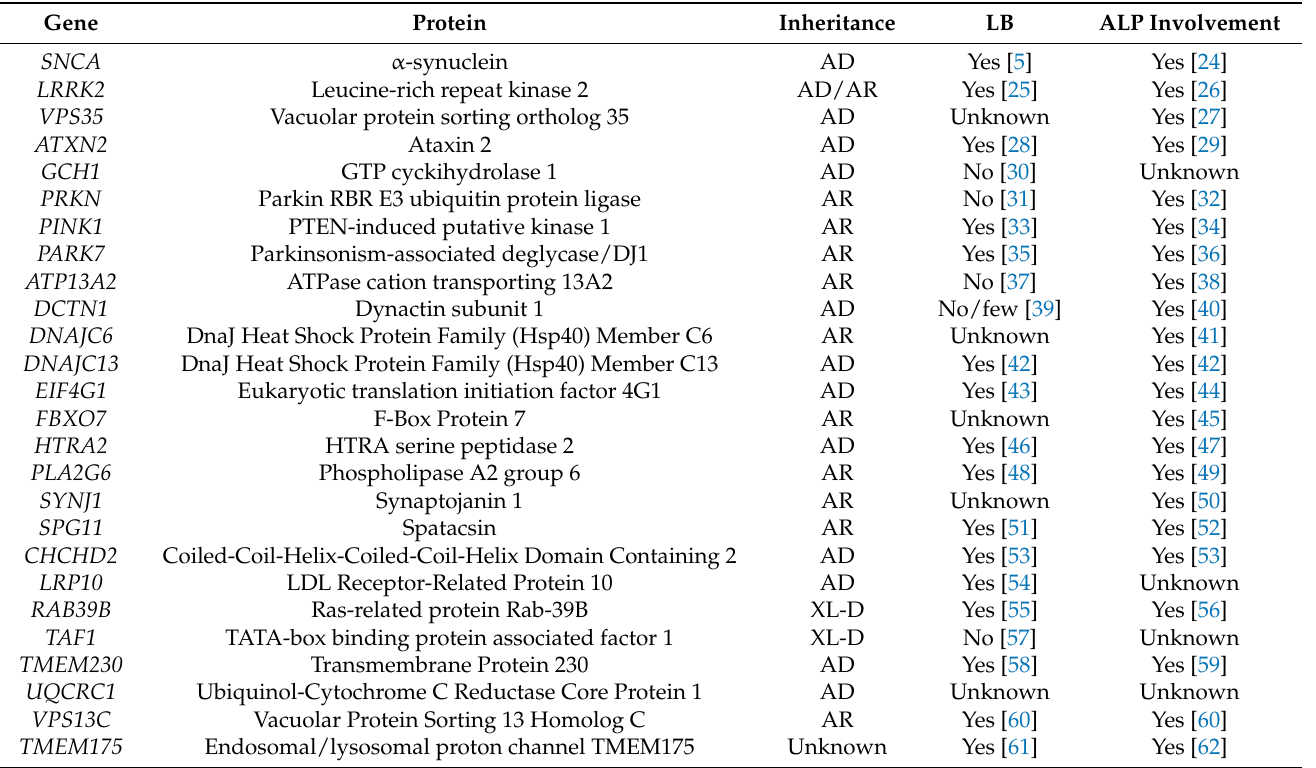
Table 1. Summary of familial PD-associated genes. This table gathers the names of genes for which mutations are reported in familial PD cases, their associated protein name, their inheritance type (AD: autosomal dominant; AR: autosomal recessive; XL-D: X-linked dominant), and their involvement in LB hallmark and